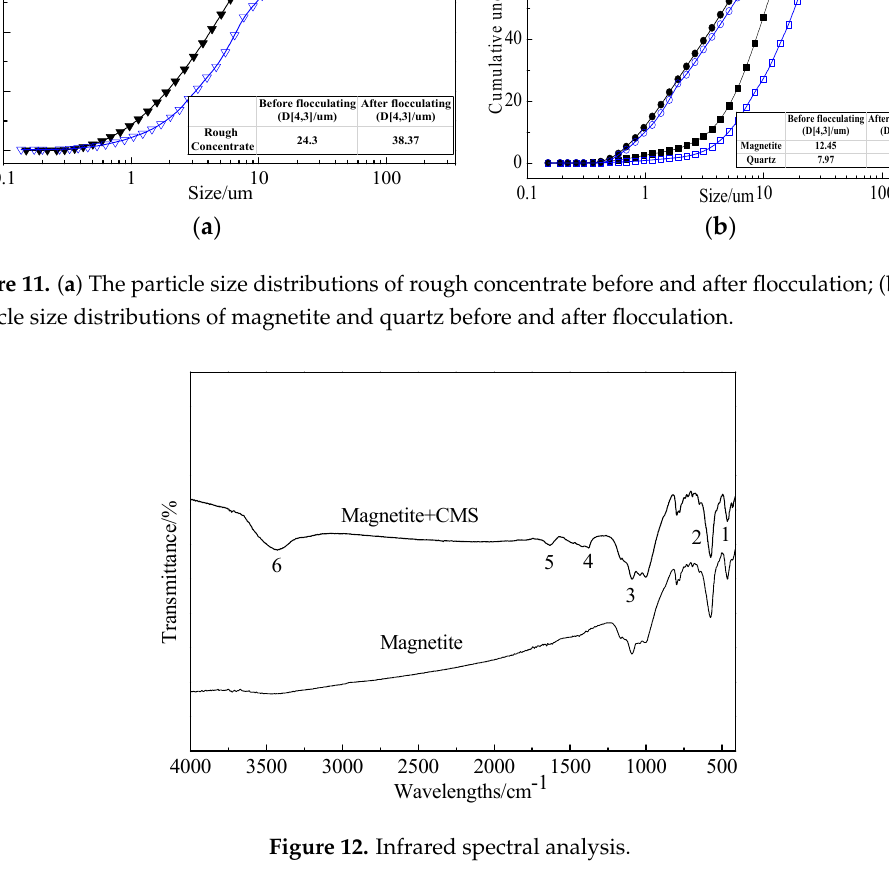
Table 4. Fitting results for each binding energy peak. a: Binding energy peak after flocculation; b: Binding energy peak before